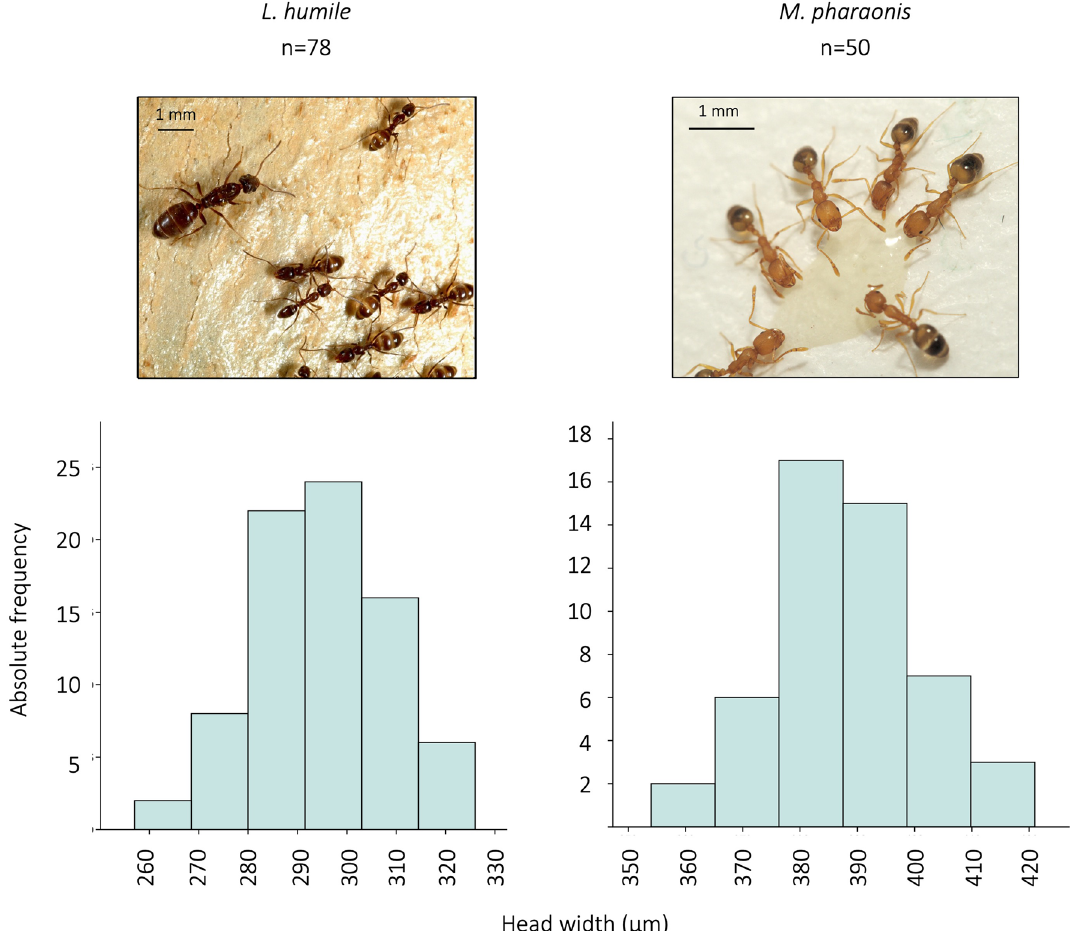
Figure 1. Worker size distributions for Linepithema humile and Monomorium pharaonis . The plots show the absolute frequencies of workers with different head widths. Both species exhibit a unimodal worker size distribution (i.e., workers are monomorphic). Images: L. humile : ©Phil Lester, used with permission; M. pharaonis : Зeмлepoйкин, CC BY-SA